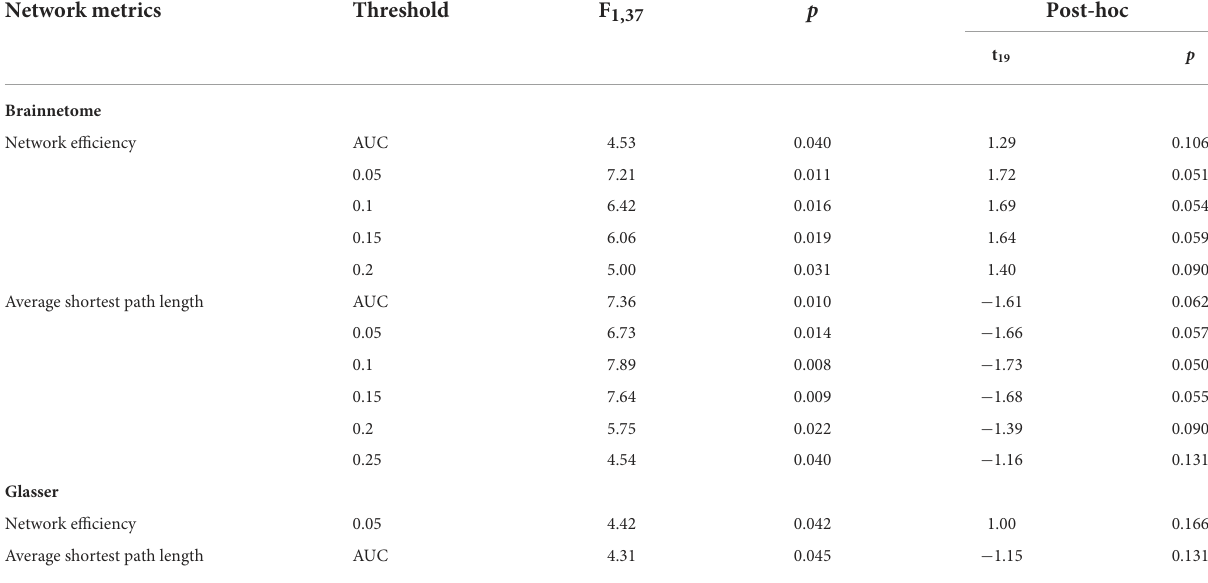
TABLE 3 Significant results of the mixed-design ANOVA for the global network metrics at different thresholds. Network